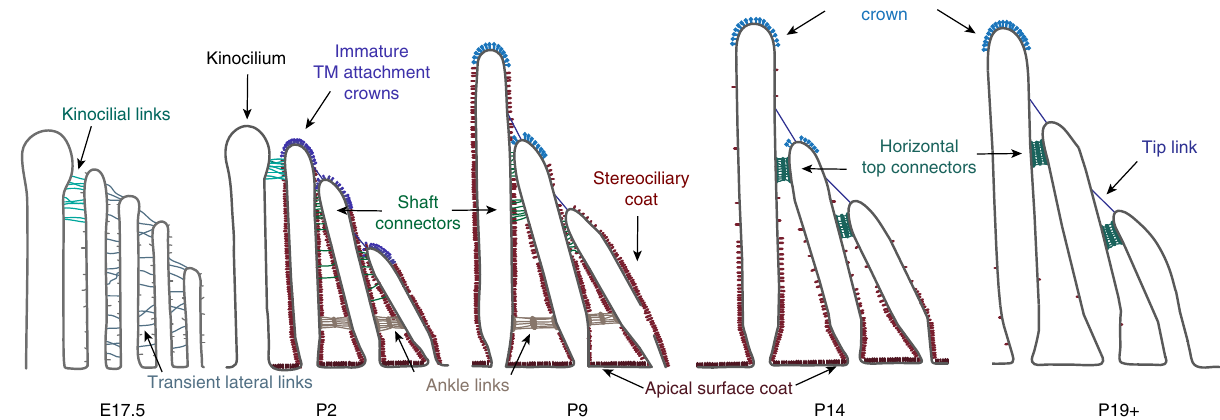
Fig. 1 Links between stereocilia. Schematic illustration of the different types of links between the stereocilia in OHCs at different stages during development. Reproduced with permission from ref. 4 . All rights